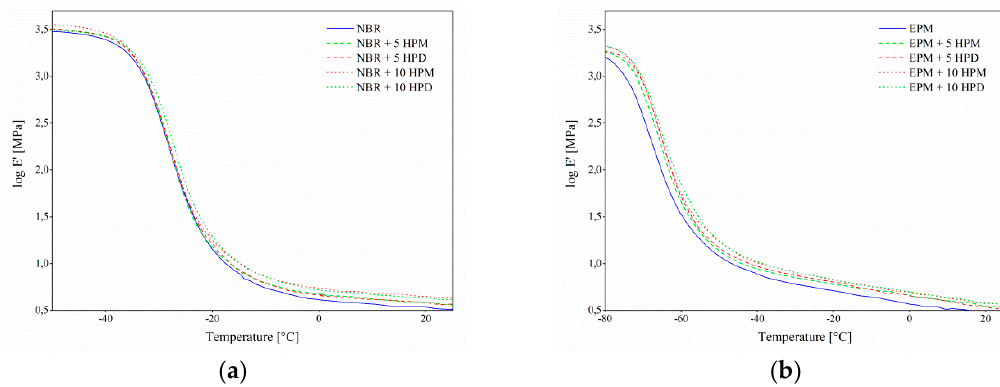
Figure 11. Storage modulus of ( a ) NBR and ( b ) EPM composites filled with hybrid pigments as a function of temperature. Polymers 2018 , 10 , x FOR PEER REVIEW 13 of 19